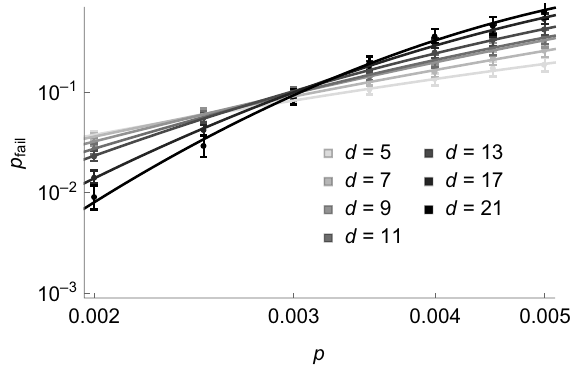
FIG. 35. Failure probability p fail of the noisy-syndrome pro- jection decoder for n cyc = d rounds of circuit noise and various distances d